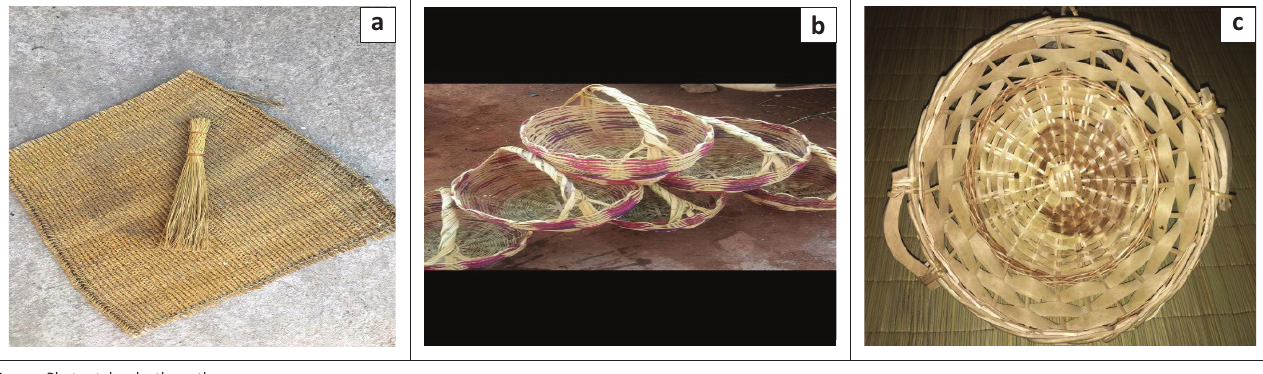
FIGURE 1: Woven art products. (a), The straw Basotho mat and small broom used when selecting beans; (b), The mantji [baskets] made by the Swati people and used to carry fruits and vegetables, and (c) a similar basket used in the home for fruit storage.